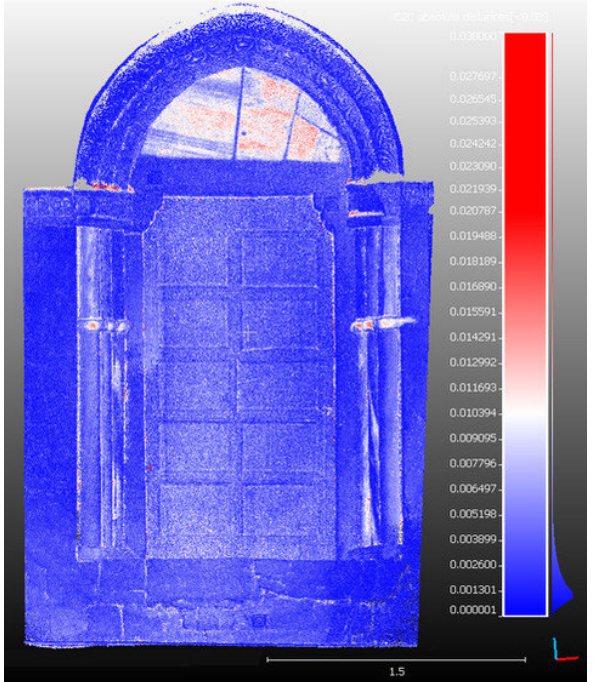
Figure 4. C2C distances analysis performed in CloudCompare These deviations are the same identified through the preliminary roughness analysis and are justifiable by two main factors: the